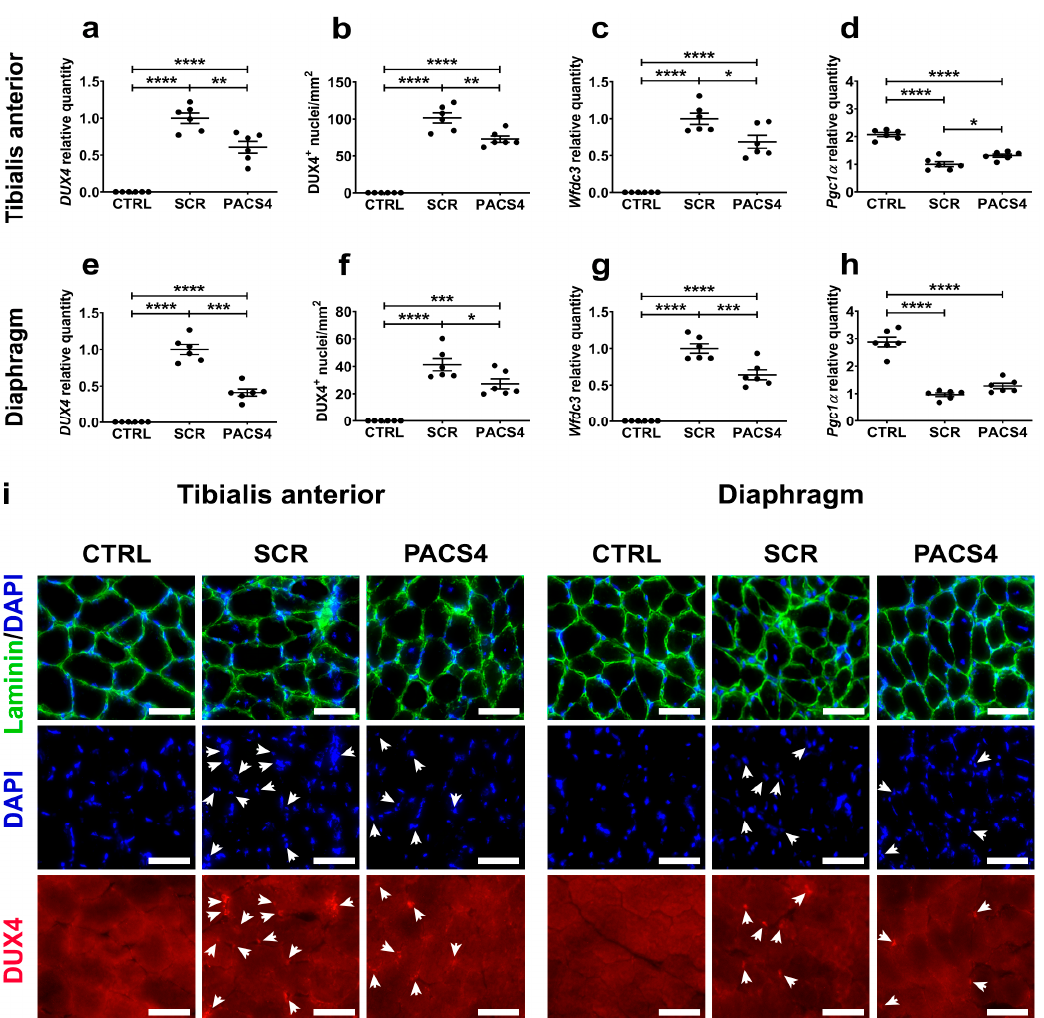
Figure 3. vivoPMO-PACS4 treatment downregulated the expression of DUX4 and murine DUX4- related genes. Following chronic TMX-induced DUX4 expression and an 8-week treatment with vivoPMOs, mRNA levels of DUX4 and DUX4-related genes, and DUX4 protein levels in ( a – d ) the tibialis anterior and ( e – h ) the diaphragm muscles were evaluated. mRNA expression of ( a , e ) DUX4 and ( c , d , g , h ) DUX4-related genes was quantified by qRT-PCR as relative to the corresponding Gapdh level and expressed as a fold-change of the SCR value obtained by the same way. ( b , f ) Muscle sections were immunostained with DUX4 and laminin, and nuclei were stained with DAPI. The number of myonuclei positive with DUX4 was manually counted and expressed as the total DUX4+ nuclei per mm 2 of the transverse muscle section. Data are shown as means ± SEM; n = 6. Statistical comparison was by one-way ANOVA followed by Tukey’s multiple comparisons test; * p < 0.05, ** p < 0.01, *** p < 0.001, **** p < 0.0001. ( i ) Representative images are shown at a magnification of × 200; scale bars = 50 µ m; white arrows indicate DUX4+